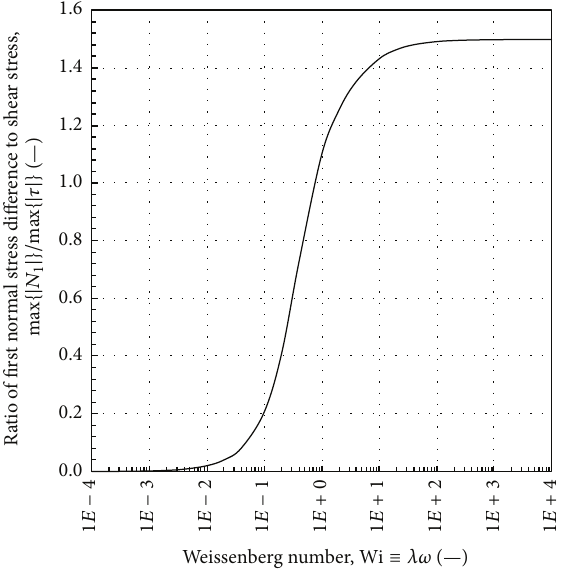
Figure 9: Ratio of maximum first normal stress difference to maxi- mum (nominal) shear stress magnitudes experienced in oscillatory simple shear flow, as a function of the Weissenberg number, in the limit of zero (or very small) Bingham number, according to Saramito’s first